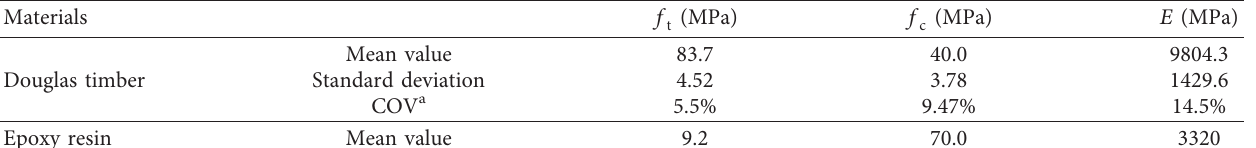
Table 1: Material properties of timber and PRF.